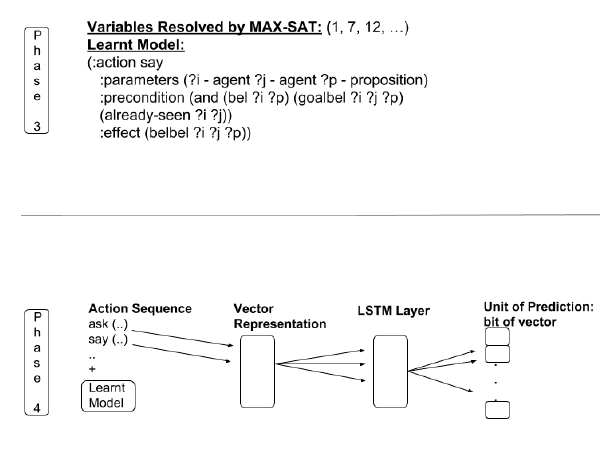
Figure 3: Illustration of Phases 3 and 4 of our approach. Phase 3 involves solving of the formulated constraints as a SAT problem to reconstruct the underlying model. Phase 4 involves using the pre- viously learnt model to perform sequence labelling on the speech acts comprising the training